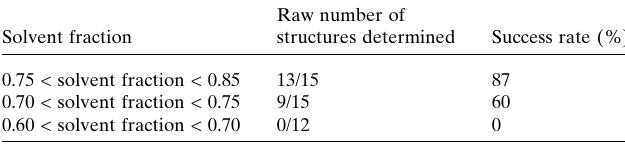
Table 2 Overall success rate for the phase determination procedure as a function of solvent content.